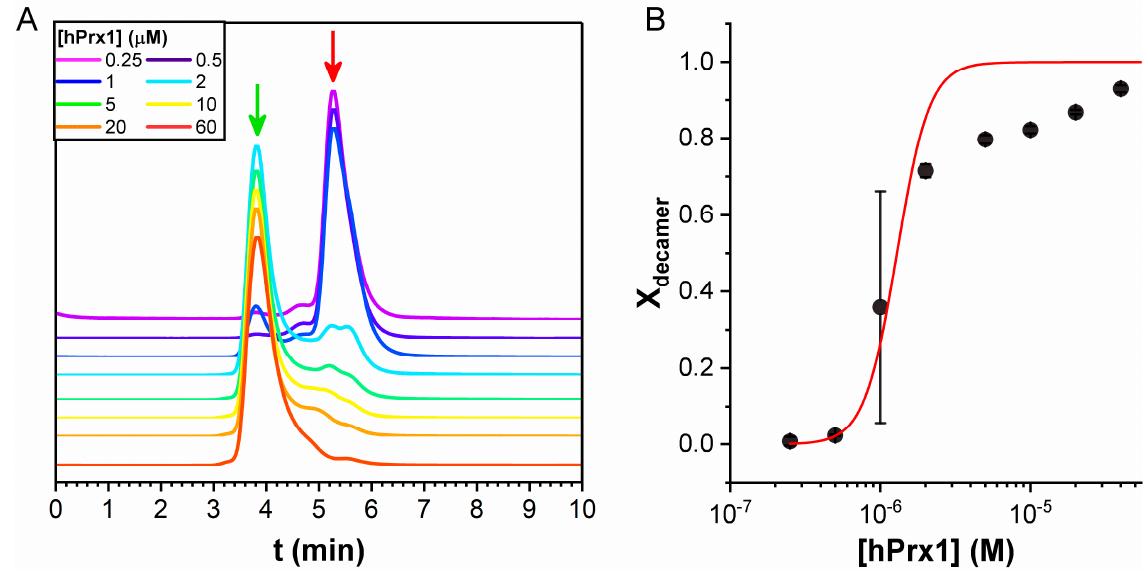
Figure 5. Dissociation of hPrx1 studied by SEC . ( A ) Chromatograms obtained at different initial hPrx1 concentrations, showing the decamer at 3.9 min (green arrow) and the dimer at 5.2 min (red arrow). ( B ) Dissociation curve of the calculated X decamer from the area under the curves as a function of hPrx1 concentration. Data are represented as the average ± standard deviation from two independent experiments.